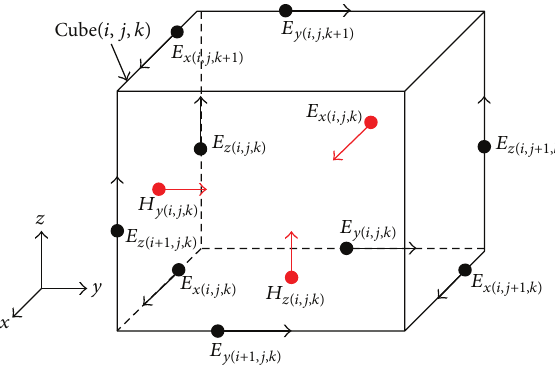
Figure 5: Unit cell in a rectangular coordinate